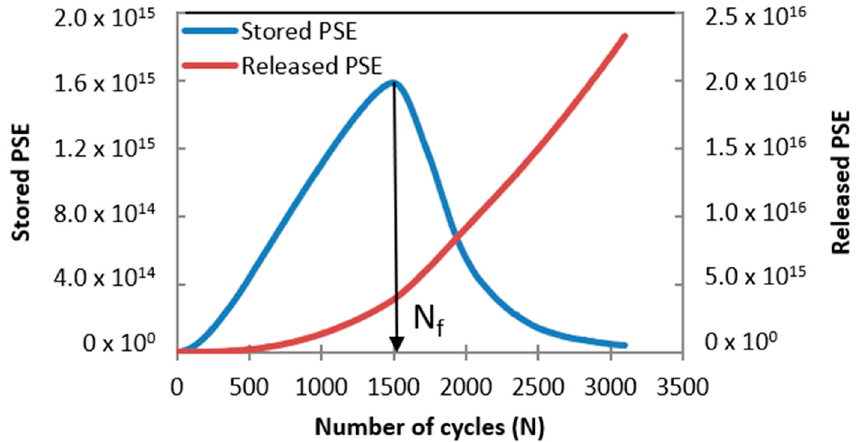
Figure 5. PSE-based failure de fi nition.